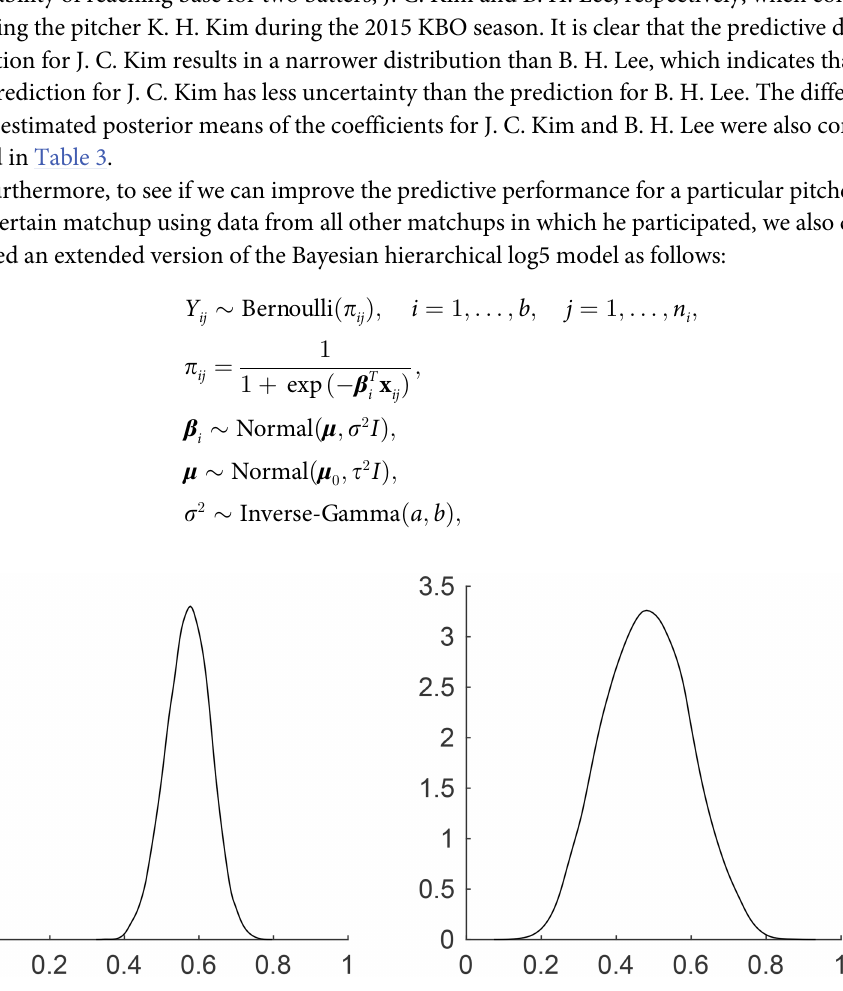
Fig 1. Illustration of the predictive distributions for two different players (Left: J. C. Kim; Right: B. H. Lee).